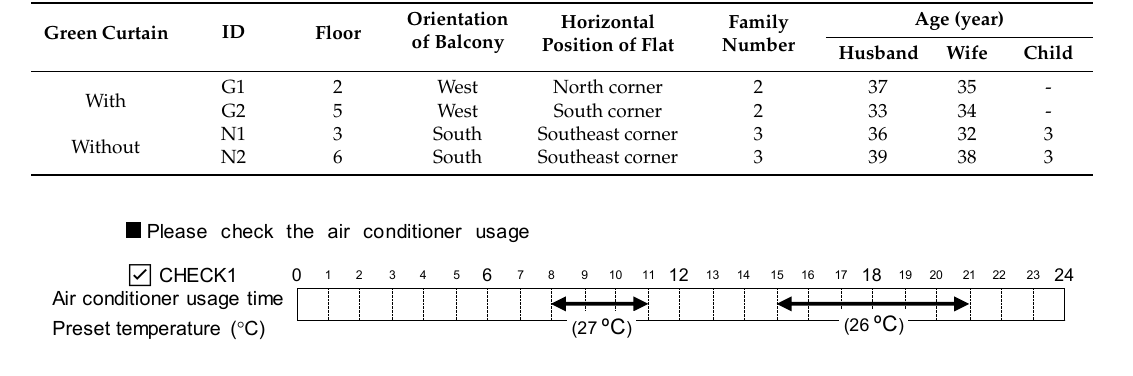
Figure 6. Investigated condominium, balcony, and floor plans. Table 2. The profile of investigated households.